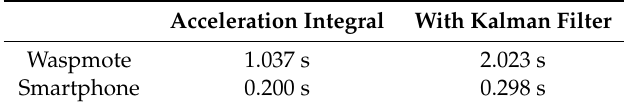
Table 7. Computation time with Waspmote and